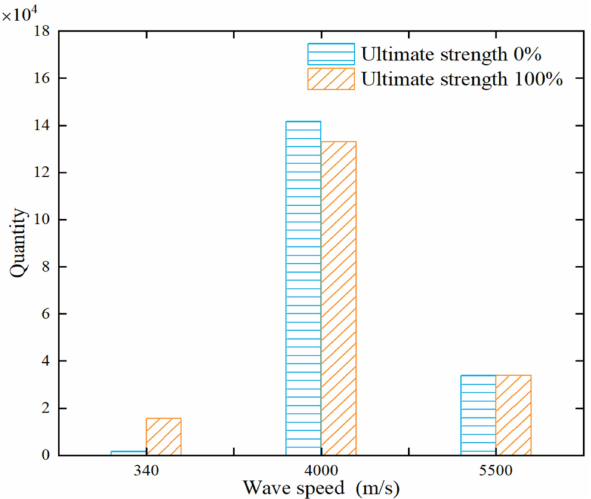
Figure 13. Statistics of the number of speeds assigned.